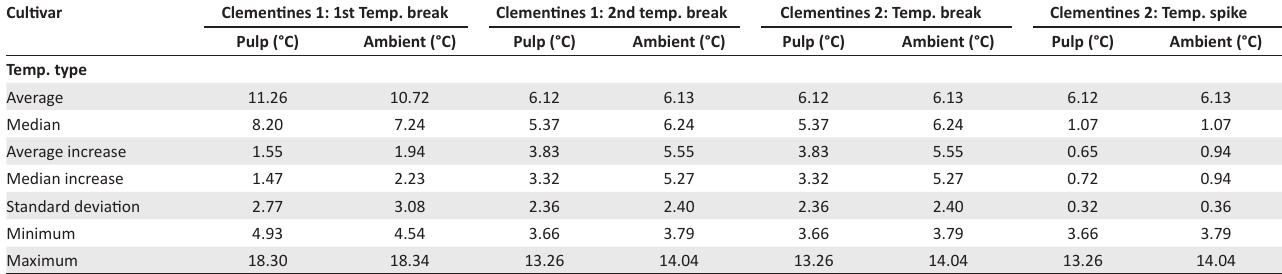
TABLE 3: Temperature dispersion of clementines loads one and two: Cold storage. Cultivar